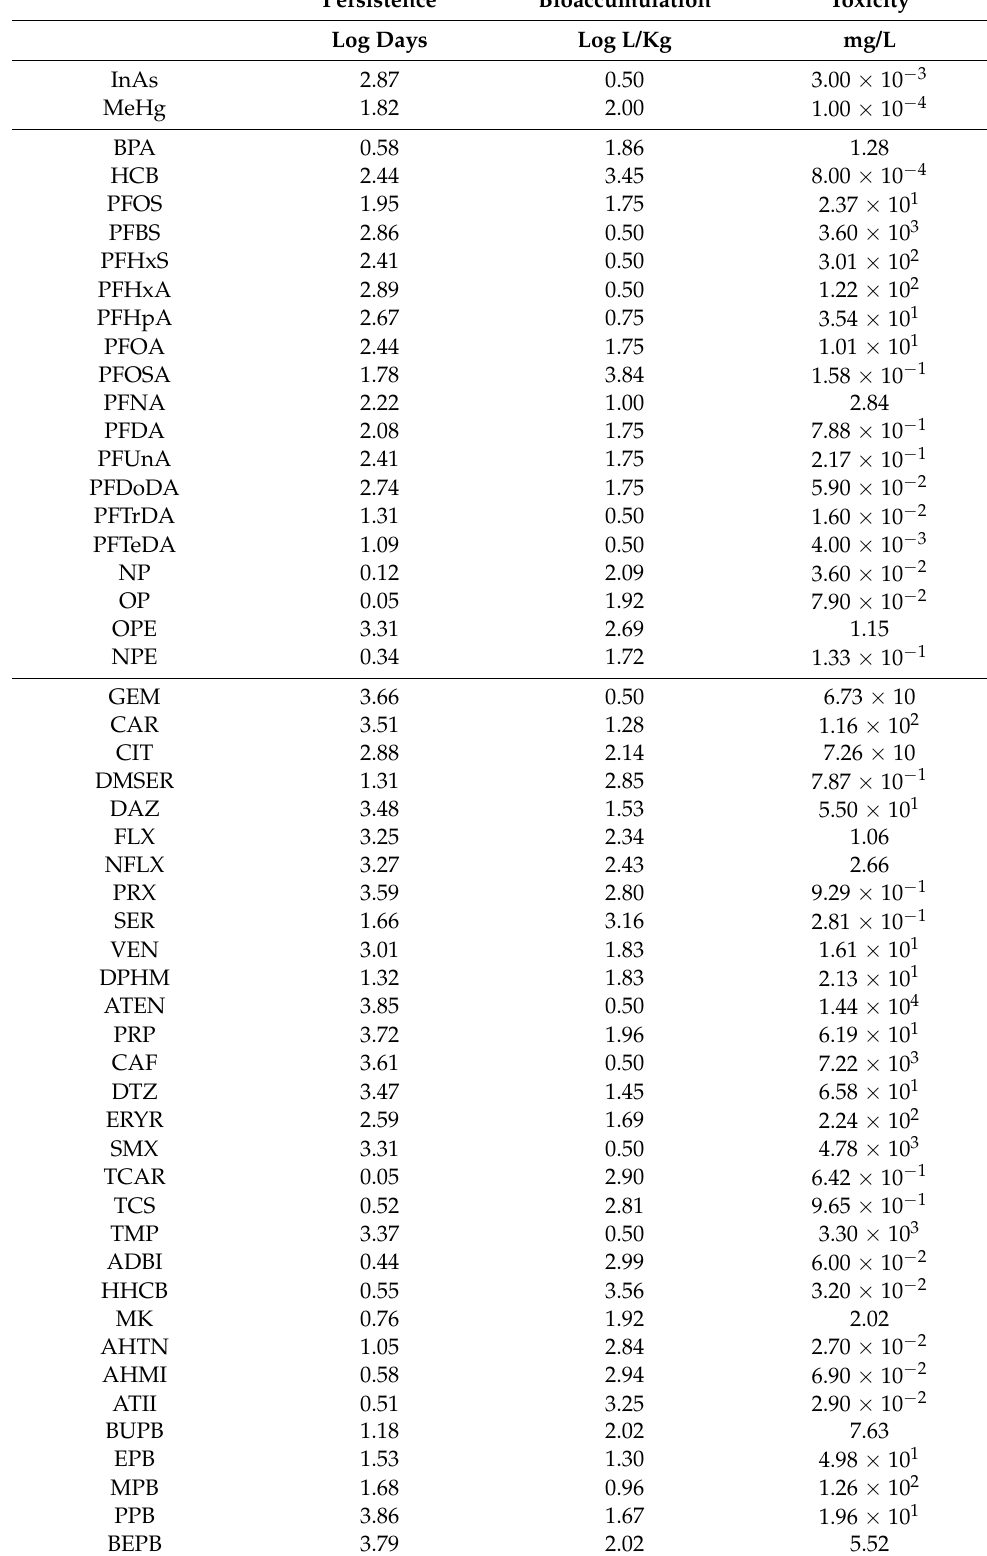
Table 4. Persistence, bioaccumulation and toxicity parameters for the 62 emerging